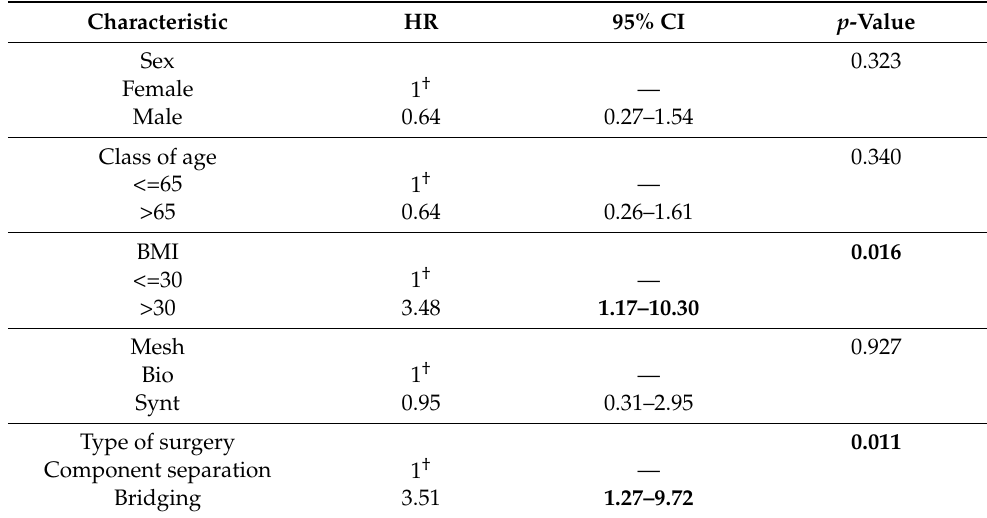
Table 4. Cox regression model for VH